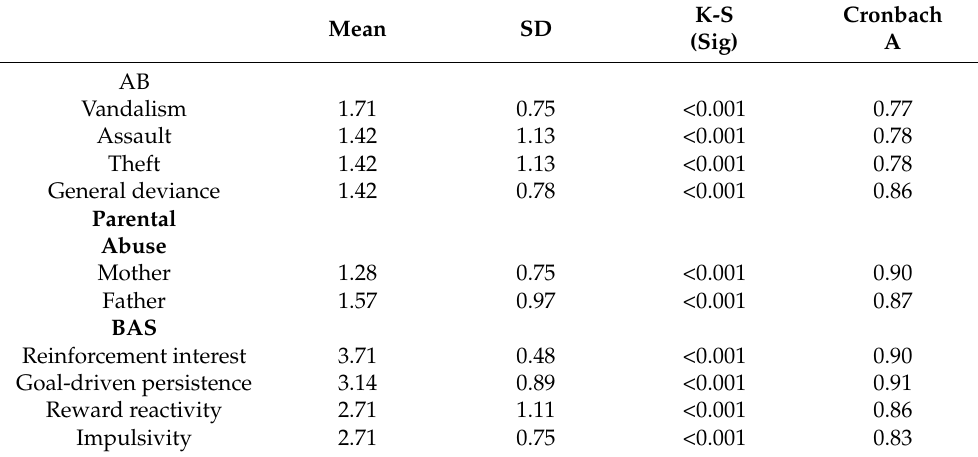
Table 1. Descriptive Statistics of the scales.